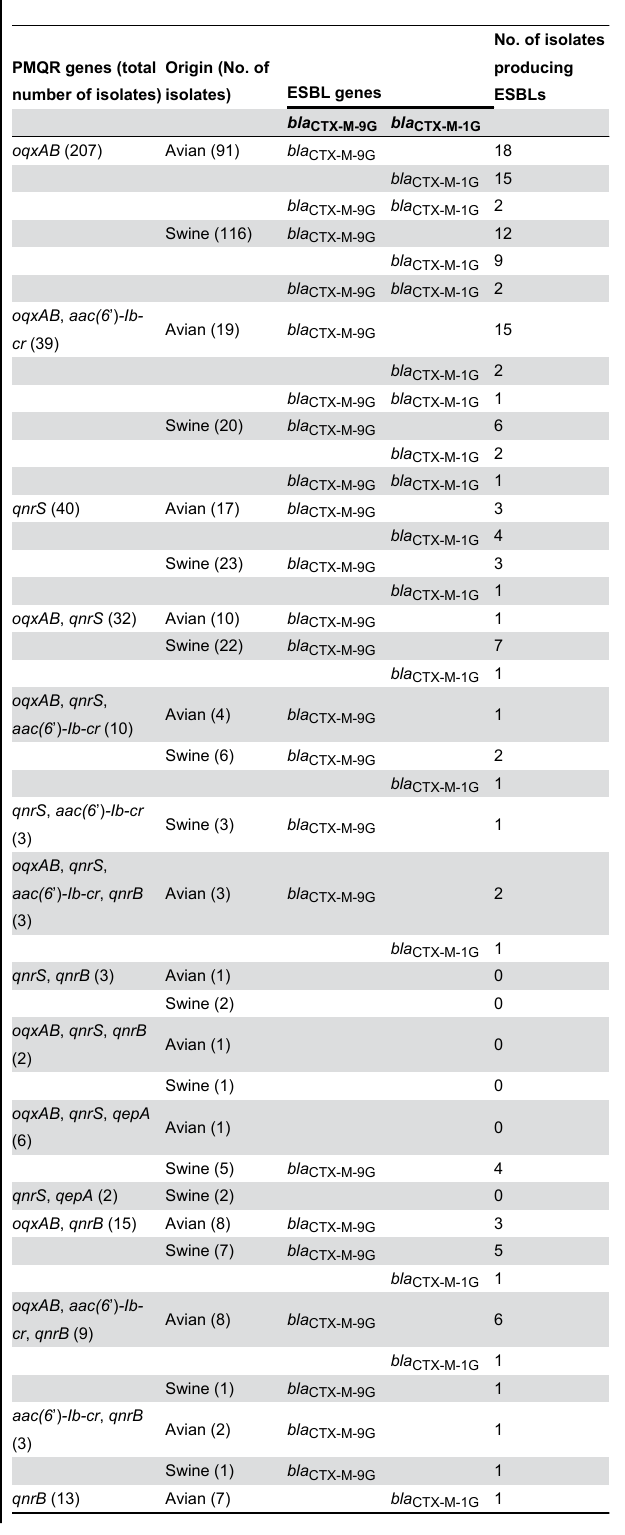
Table 1. Distribution of ESBL genes among 429 PMQR- positive E. coli isolates of food-producing animals.